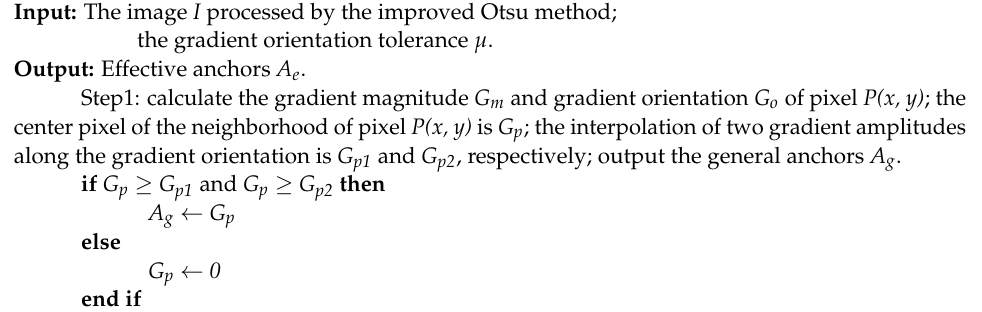
Algorithm 2 Anchor map extraction method combined with improved